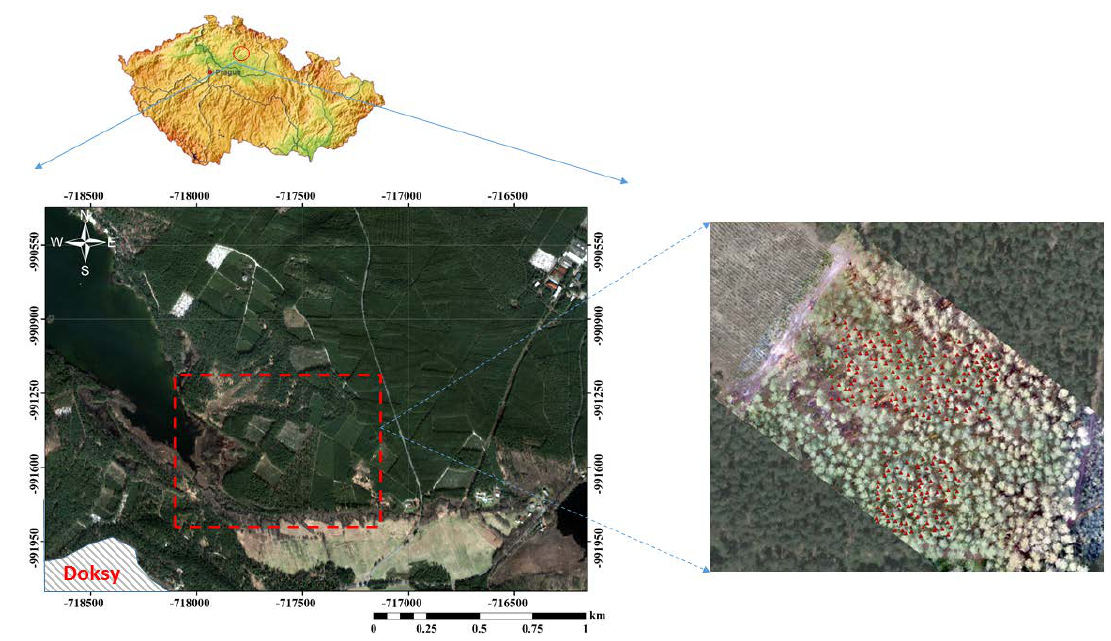
Figure 1. Location of the study area in the northern part of the Czech Republic in the local coordinate system S-JTSK/Krovak East North. Source: Google Earth (elaborated work in ArcGis for higher map detail).